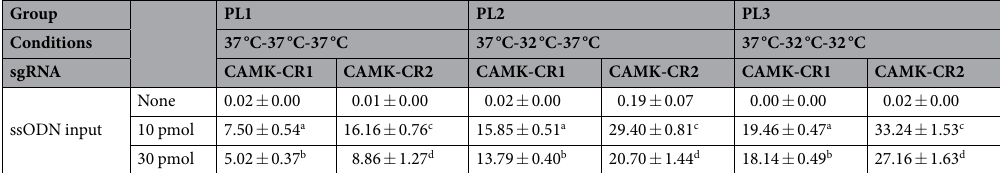
Table 1. HDR efficiencies at various temperatures at the CAMK2D locus in mc-iPSCs as determined by ddPCR. The experiments were carried out at different temperatures as described in “material and methods” and HDR efficiencies were determined by ddPCR using probes specific for wild type and mutant sequences at the CAMK2D locus. Data presented as mean percentage of droplets containing the mutant allele ± standard error from three independent experiments and eight biological replicates.The significance of HDR efficiency difference among the three temperature conditions for each sgRNA and ssODN treatment were analyzed by one way ANOVA (a,b,c,d: one way ANOVA P < 0.0001, follow-up Dunnett’s multiple comparison, PL2 versus PL1: P = 0.0001, PL3 versus PL1: P =